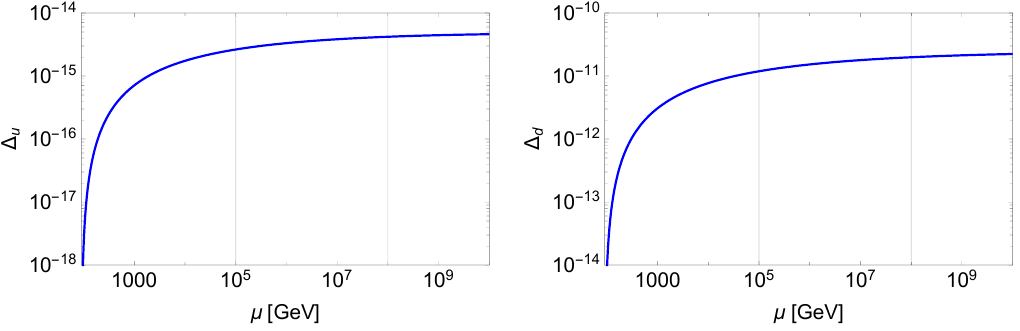
Figure 10 . RGE running of the parameter de(cid:12)ned in eq. (5.1) from m Z with the benchmark parameters given in table 3.